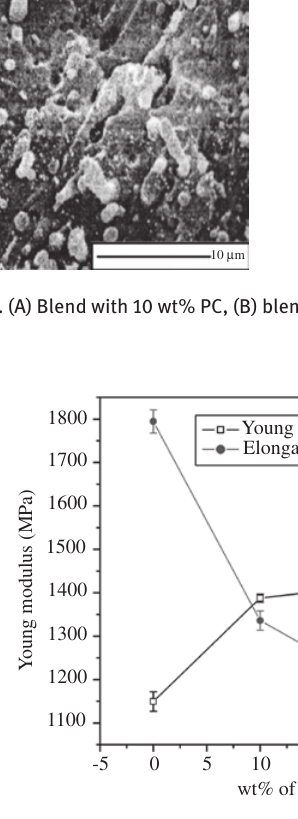
Figure 3: Young’s modulus and elongation at break of PP/PC